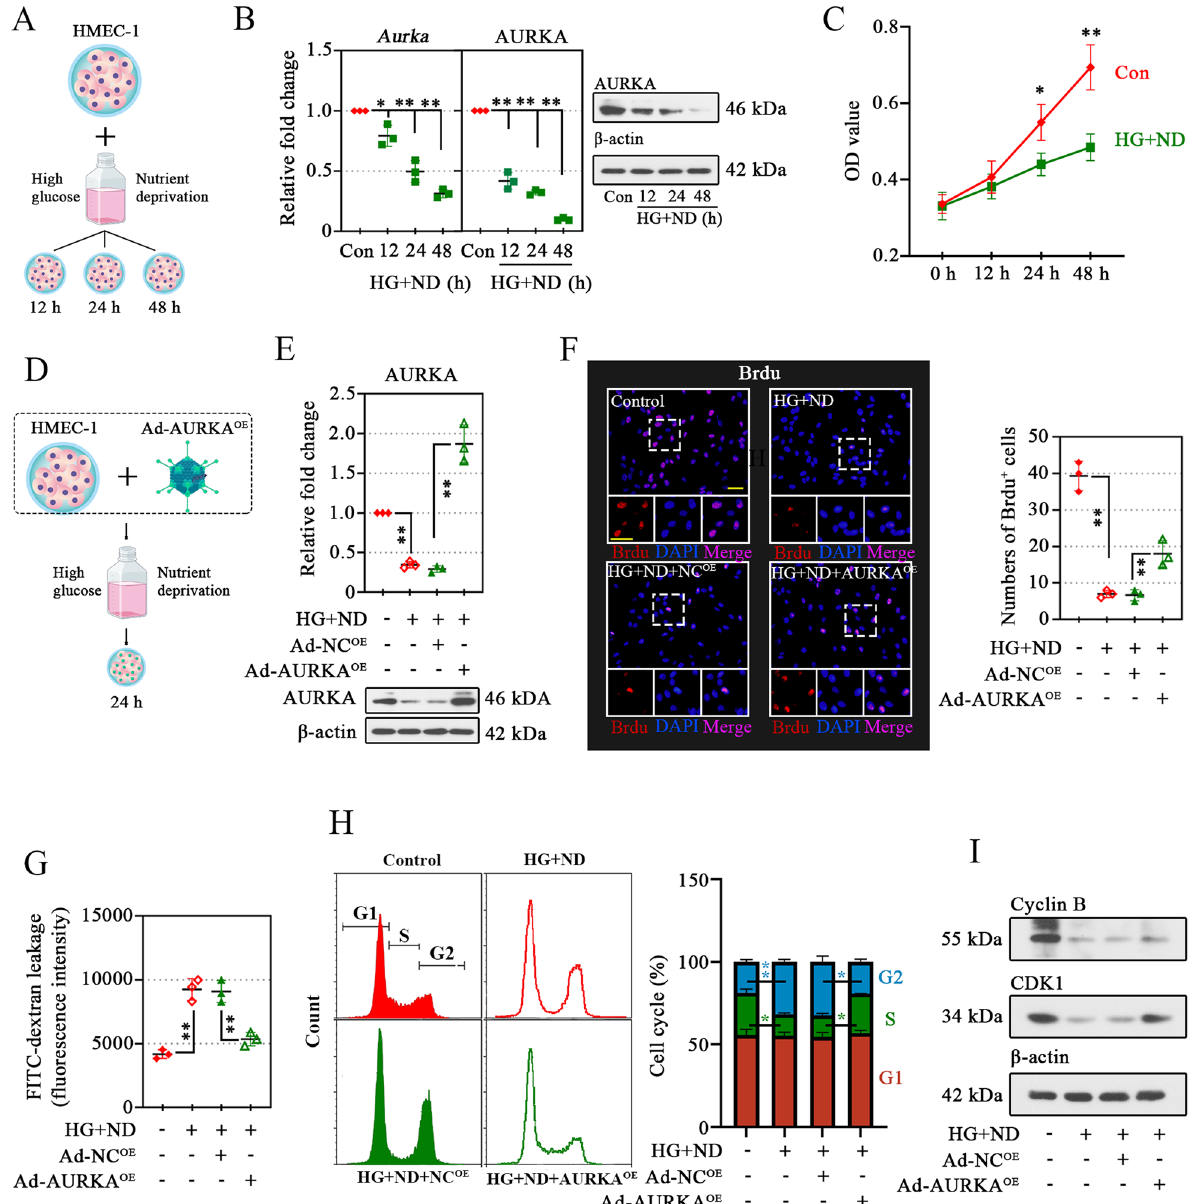
Fig. 2 Overexpression of AURKA enhances the proliferation of HMEC-1 after high glucose and nutrient deprivation injury. Human microvascular endothelial cell (HMEC-1) cells were incubated with high glucose condition (HG) with nutrition deprivation (ND) for 12, 24, or 48 h ( A ). After that, the expression validation of Aurora kinase A (AURKA) ( B ) and cell viability were analyzed ( C ). AURKA was overexpressed via transduction with adenoviral vectors and treated with medium for 24 h ( D ), and the transduction efficiency was confirmed by the protein expression of AURKA ( E ). After 24 h of transfection, the cell proliferation was evaluated using bromodeoxyuridine (Brdu) labeling, and its quantification data were shown on the right. Pink spots were scored as positive-stained Brdu (scale bar, 50 μm) ( F ). The endothelial permeability of cells was tested using fluorescein isothiocyanate (FITC)-dextran ( G ). Flow cytometry analysis on cell cycle was analyzed ( H ), and the protein expression of cell cycle related proteins Cyclin B1 and CDK1 was measured using Western blotting ( I ). Data were represented as mean standard deviation (SD). * P < 0.05, ** P < 0.01. Each dot indicated a ± biological replicate, n =